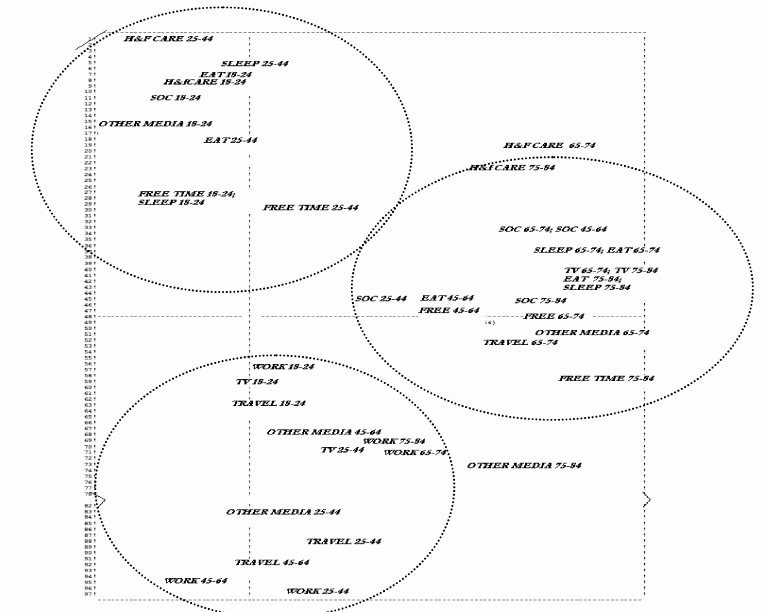
Figure 4 – Plot of mean-variables (activities) points across five age classes on the first compromise factorial